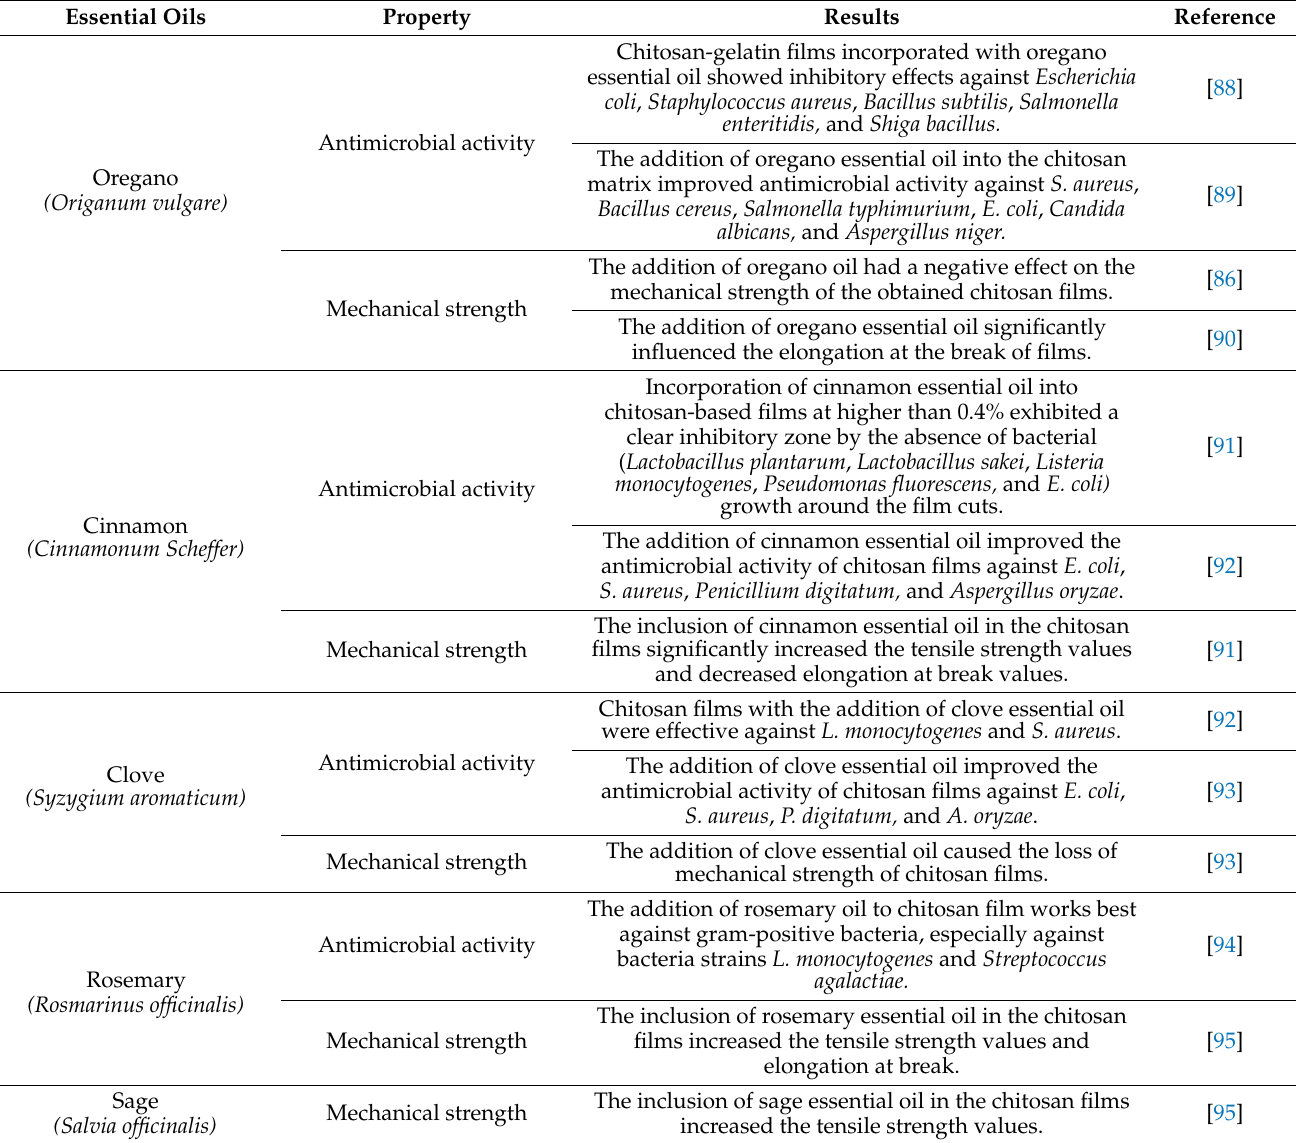
Table 1. The list of the most common used essential oils and their influence on the properties of the obtained chitosan-based